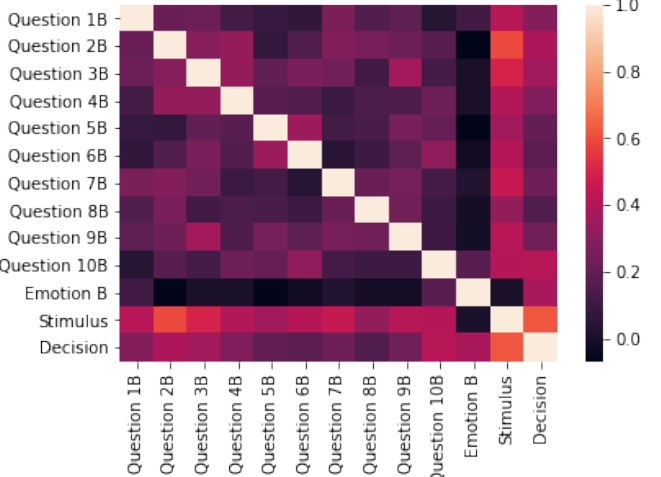
Figure 5. Correlation Matrix.